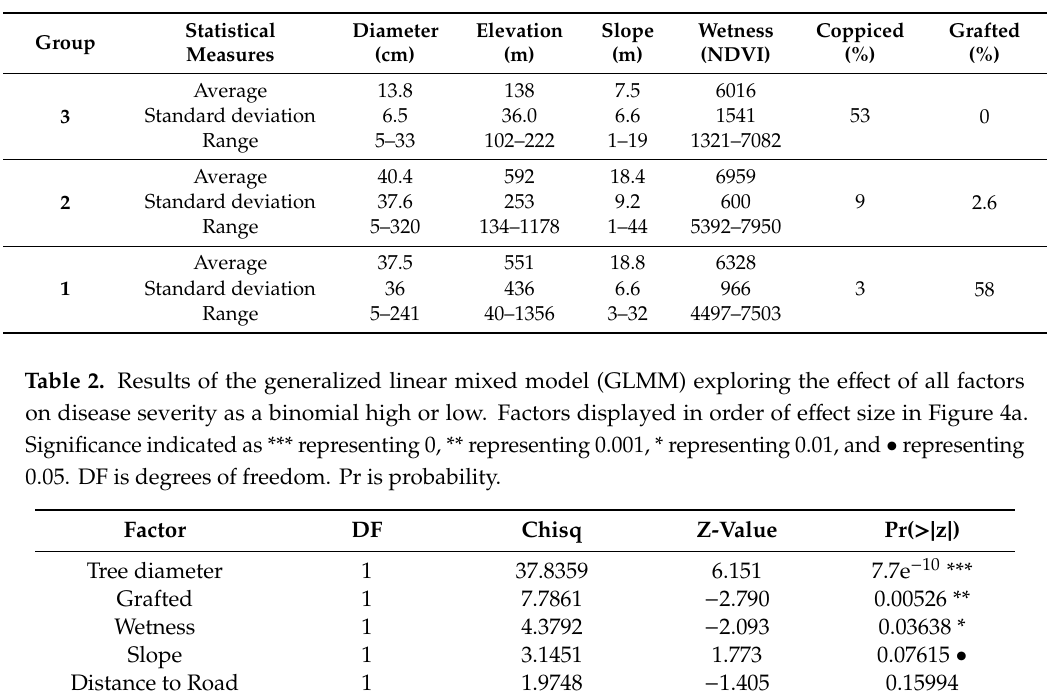
Table 1. Summarizing statistics for recorded factors for blight severity groups as determined by multiple correspondence analysis (MCA).